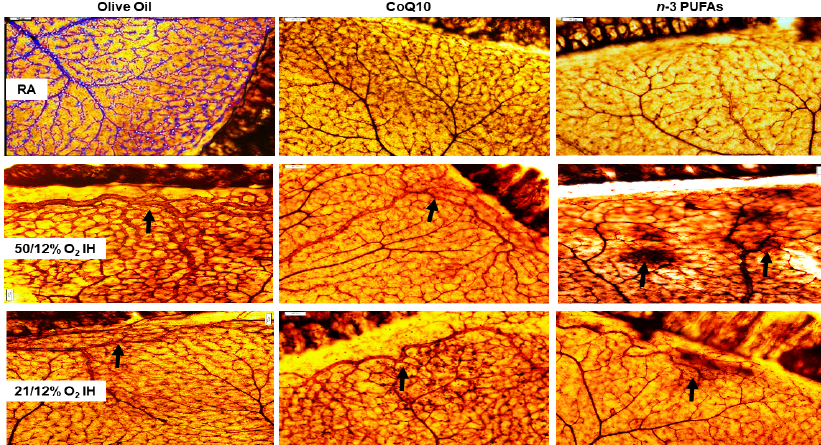
Figure 4. Representative adenosine diphosphatase (ADPase)-stained retinal flatmount from 21-day-old rat exposed to RA ( top panels ), 50/12% O 2 IH ( middle panels ), and 21/12% O 2 IH ( lower panels ). Animals were supplemented with olive oil ( left panels ), CoQ10 ( middle panels ), or n -3 PUFAs ( right panels ). The representative flatmount from the RA-exposed, olive oil-treated rats shows example of WimRetina analysis for the quantitation of the vascular density parameters listed in Table 5. Images are 10× magnification. Scale bar, 100 µm.